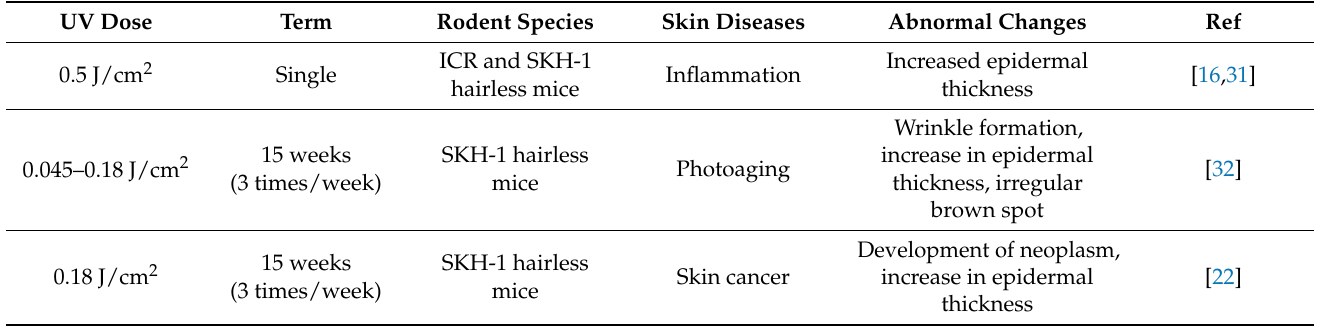
Table 1. UV-induced skin diseases in mouse